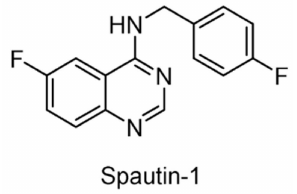
Figure 19. Structure of